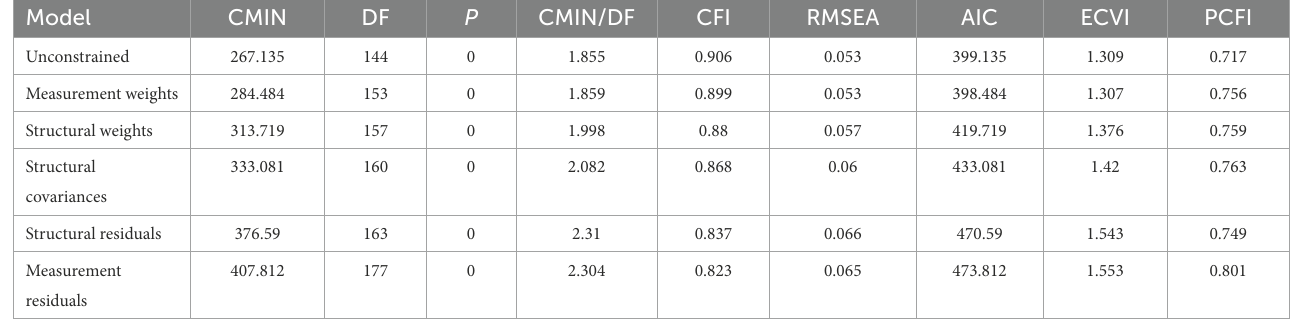
TABLE 5 Multi-group analysis adaptation results.